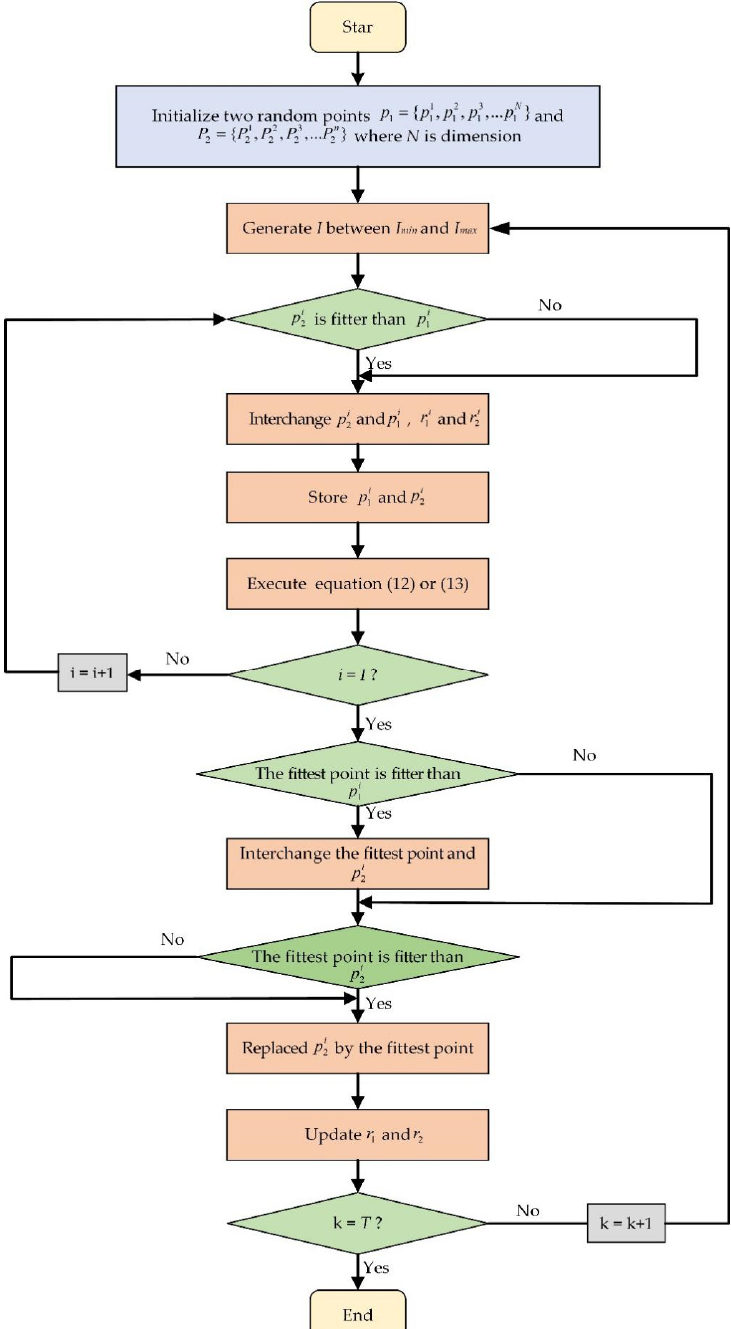
Figure 2. The flowchart of